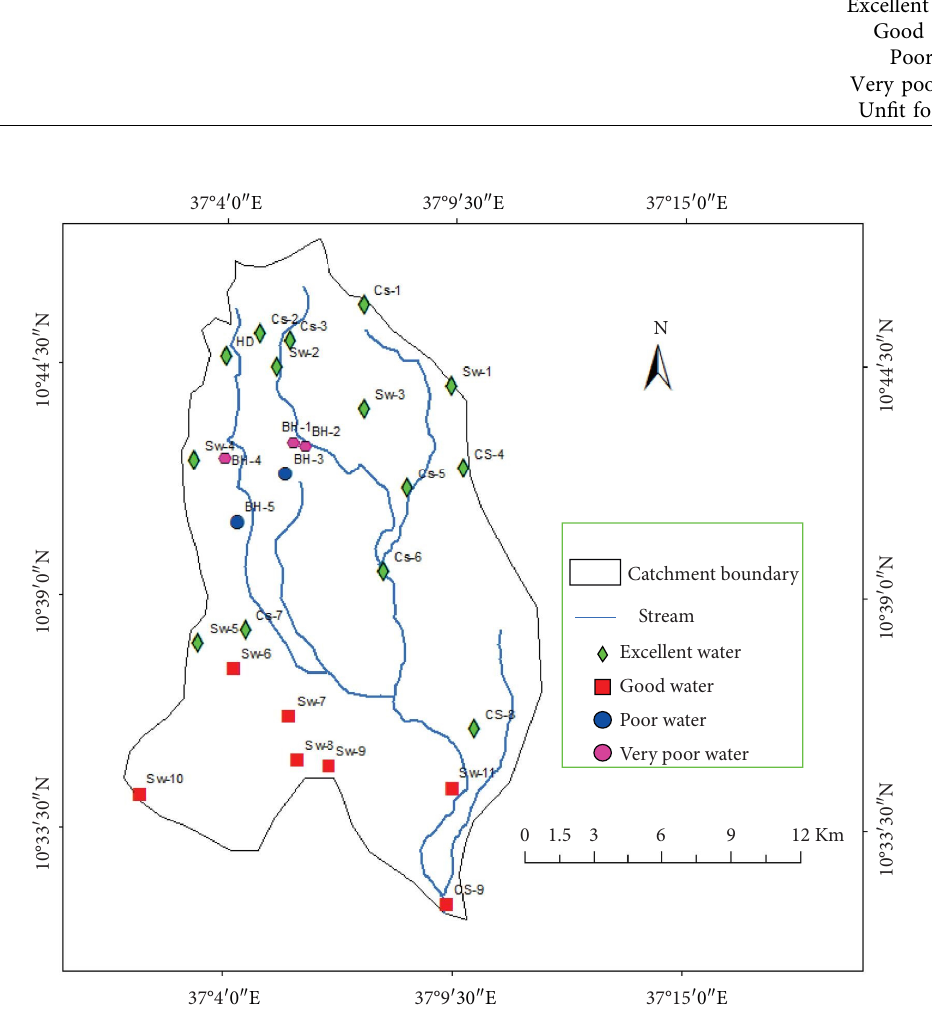
Figure 22: Spatial variability map of